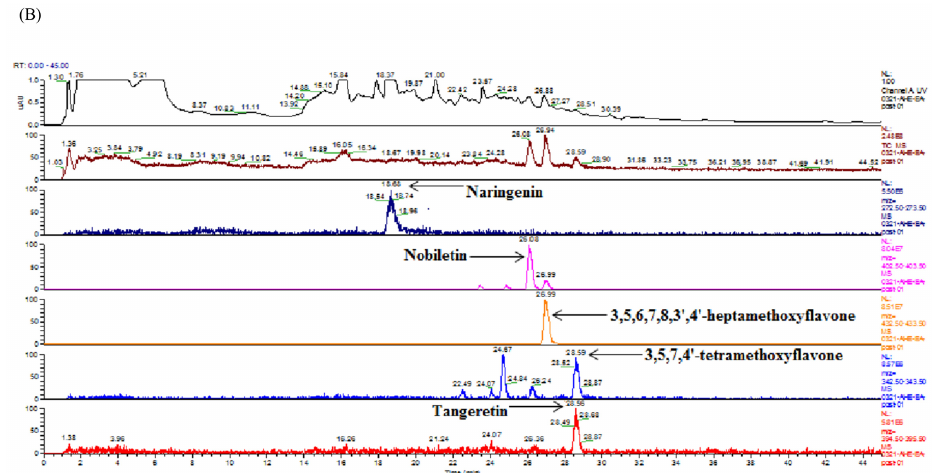
Figure 7. Total ion chromatogram of extracts from adlay ( A ) ATE-EA and ( B ) AHE-EA.